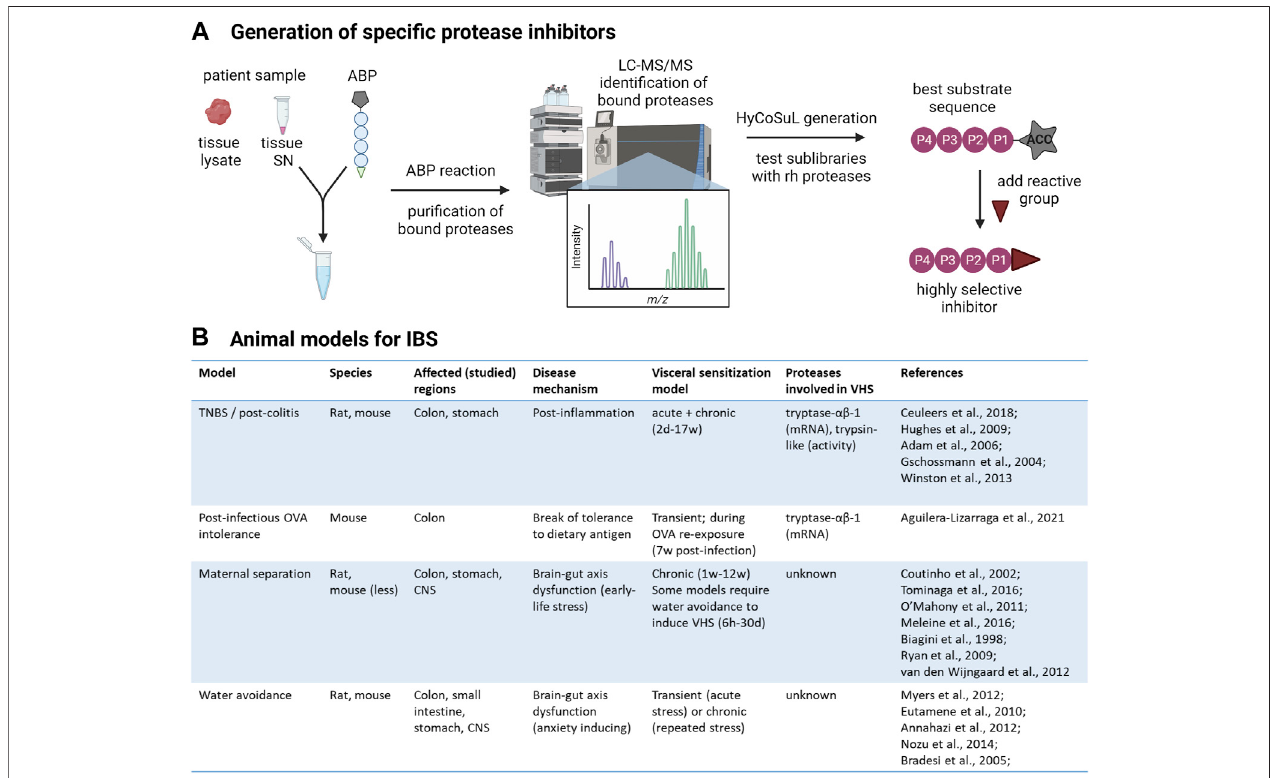
FIGURE 2 | From protease identi fi cation to inhibitor design. (A) Work fl ow to develop highly selective protease inhibitors. First, serine proteases present in patient samples, whole tissue lysate or supernatant (SN) containing secreted mediators, will be labeled with desthiobiotin-tagged activity-based probes (ABPs) speci fi c for this class. The desthiobiotin-tag of the ABP is represented as a pentagon, the circles represent the recognition element, and the reactive group that will bind the attacking protease is represented as a triangle. The bound proteases will be isolated with paramagnetic beads conjugated to streptavidin and analyzed by LC-MS/MS. This will unambiguously inform the researcher about the identity of all active serine proteases in the sample and which ones are increased in IBS patients compared to controls. Next, hybrid combinatorial substrate libraries (HyCoSuL) will be developed to determine the substrate speci fi cities of the identi fi ed protease(s). For serine proteases, three tetrapeptide sublibraries are made with a fi xed amino acid at the P1 position, according to the serine protease of interest. The protease will attack the bondbetweentheaminoacidatP1and the fl uorogenicreporter(7-aminocoumarin-4-aceticacid,ACC)attheP1 ′ positionsothathydrolysis canbemeasured inaplate reader. In each sublibrary, one of the three remaining positions in the tetrapeptide (P2-P4) has a fi xed amino acid while the remaining positions contain an equimolar